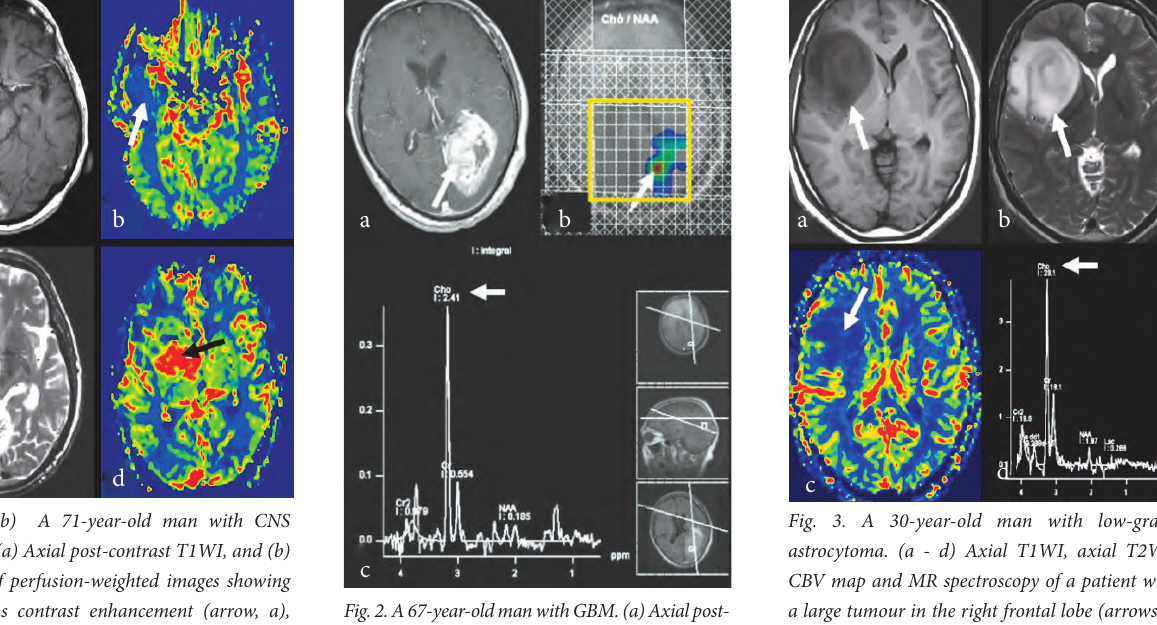
Fig. 2. A 67-year-old man with GBM. (a) Axial post- contrast T1WI. (b) MR spectroscopy colour map. (c) MR spectrum showing a tumour with strong enhancement (arrow, a) with central necrosis. The colour map shows the maximum choline/creatine ratio in the inner portion of the tumour (arrow, b).